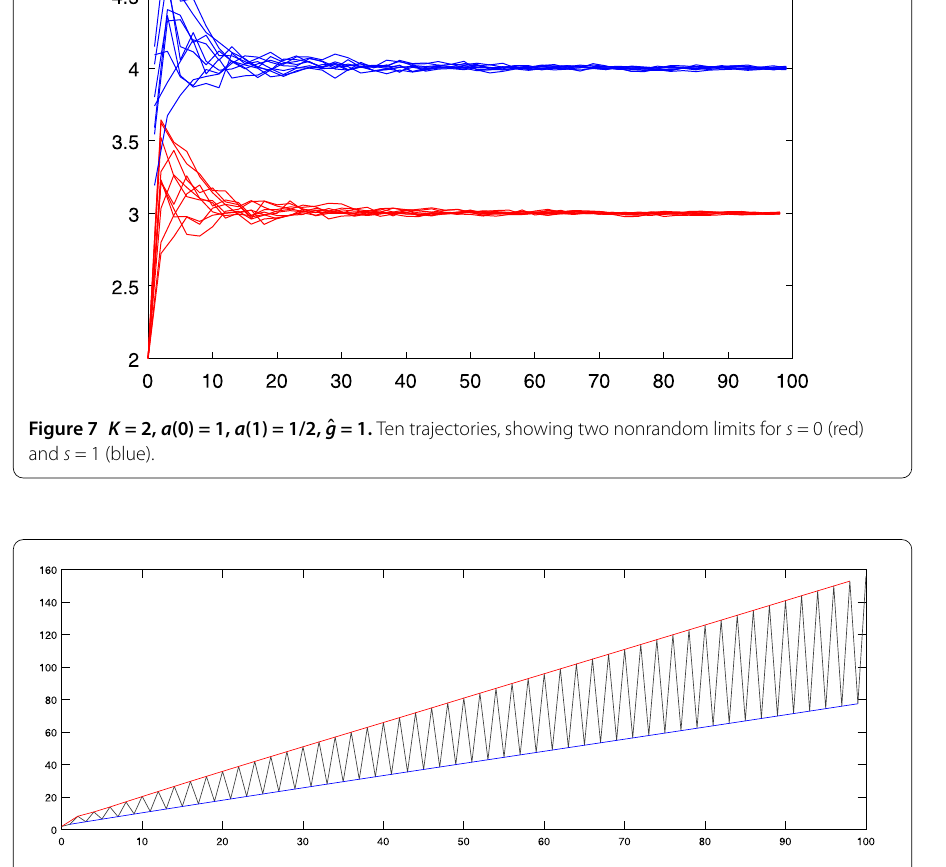
Figure 8 K = 2, a (0) = 1/2, a (1) = 2, ˆ g = 1. Sample trajectory, demonstrating the divergence of the solution, s = 0 (red) and s = 1